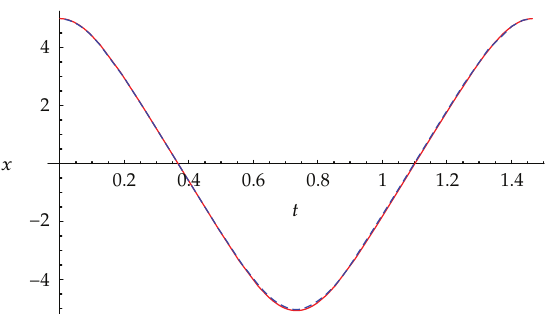
Figure 1: Comparison between the approximate solution (27) and numerical solution of (3) in the case 𝑎 = 𝑏 = 1 , 𝐴 = 5 , red solid line: numerical integration results, blue dashed line: approximate solution.